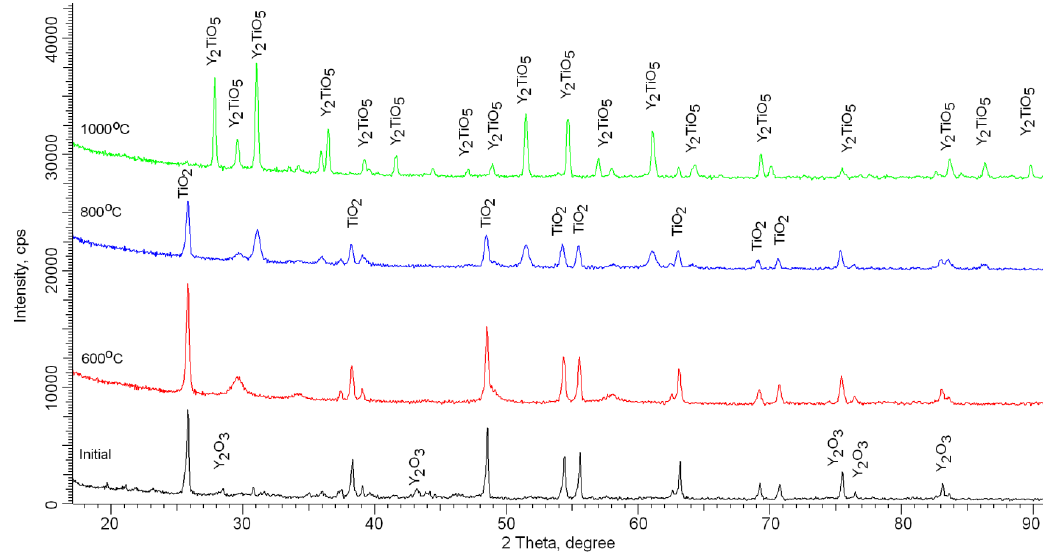
Figure 2. Dynamics of X-ray di ff raction patterns of nanostructured ceramics Y 2 O 3 / TiO 2 -Y 2 TiO 5 doped